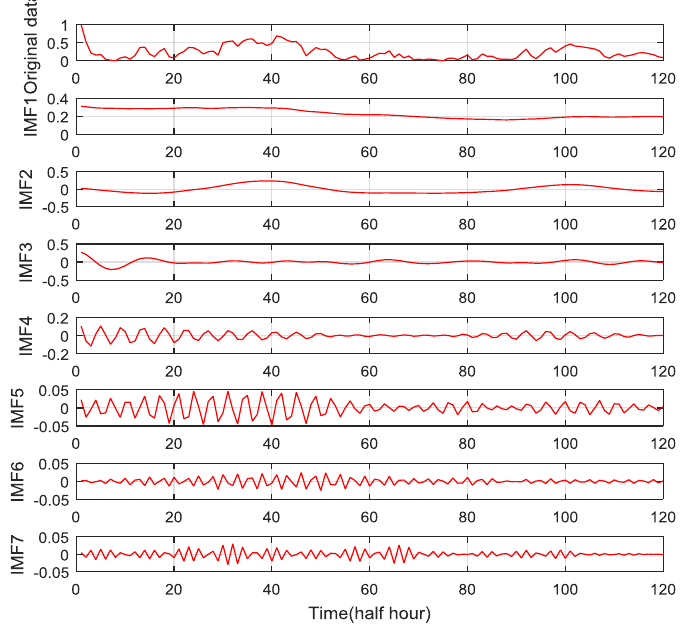
Figure 4. Decomposition results of variational mode decomposition (VMD).